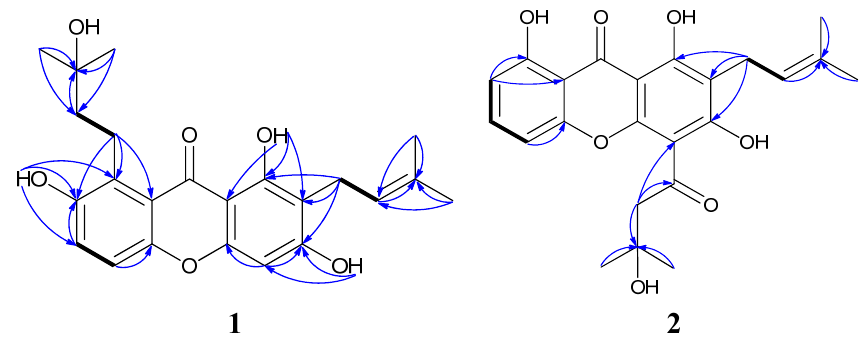
1 2 The human nasopharyngeal carcinoma cell lines CNE1, CNE2, SUNE1 and HONE1, human lung cancer cell lines A549 and GLC82, human breast cancer cell line MCF-7, and human hepatic